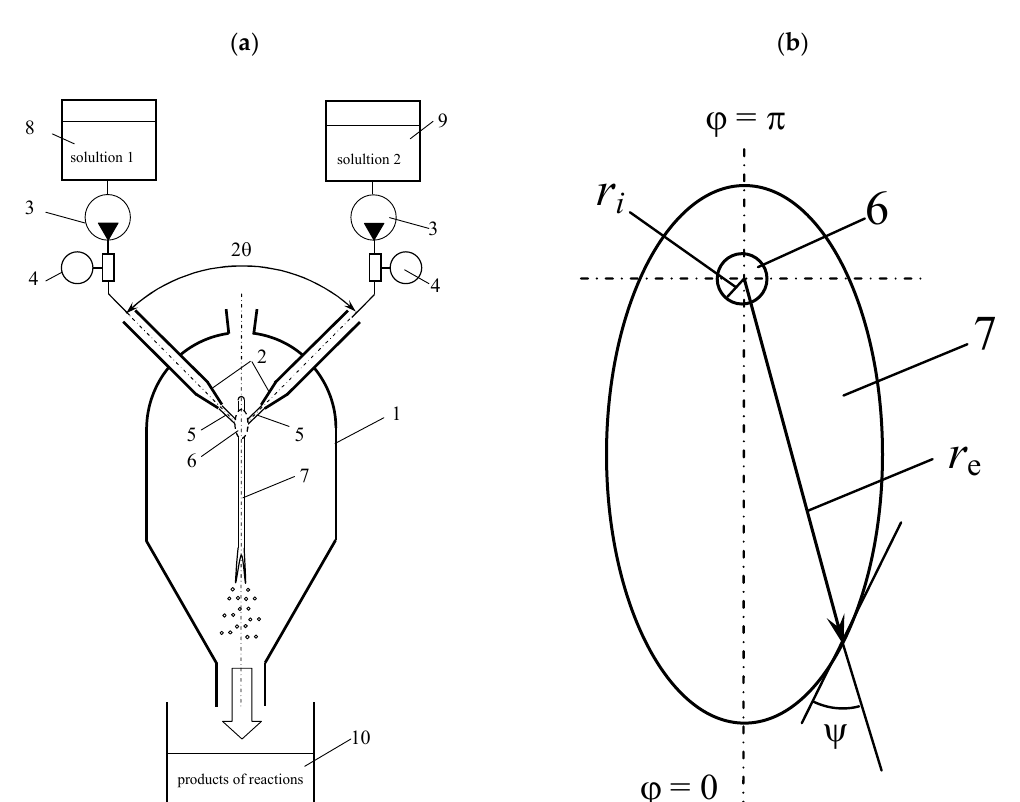
Figure 1. Laboratory setup diagram for micromixing research in an impinging jet micro-reactor with housing ( a ) and geometry of the liquid sheet ( b ): 1-housing of a microreactor with free impinging jets (MRFIJ); 2-nozzles; 3-TOPSFLO gear pumps for supplying solutions of initial components; 4-VISION ® 1005 2F66 flow meters with ILR750T 56,704 measuring block; 5-jets of solutions 1 and 2, 6-zone of active mixing of solutions 1 and 2 (volume V i ); 7-liquid sheet (volume V e ); 8, 9–feeding flasks solutions; 10-tank for collecting reaction products. 2θ = 107°.